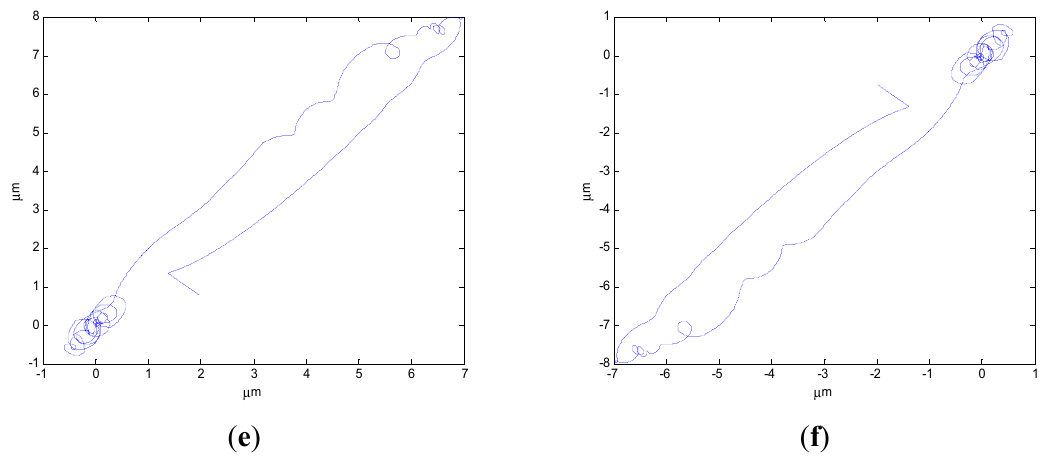
Figure 7. The curves with feedforward compensation. ( a ) Magnetic bearing torque; ( b ) Control current; ( c ) The rotor tilt angle ( d ) The rotor tilt angle velocity; ( e ) The rotor displacement of A-side ( f ) The rotor displacement of B-side; ( e ) The rotor displacement of A-side; ( f ) The rotor displacement of